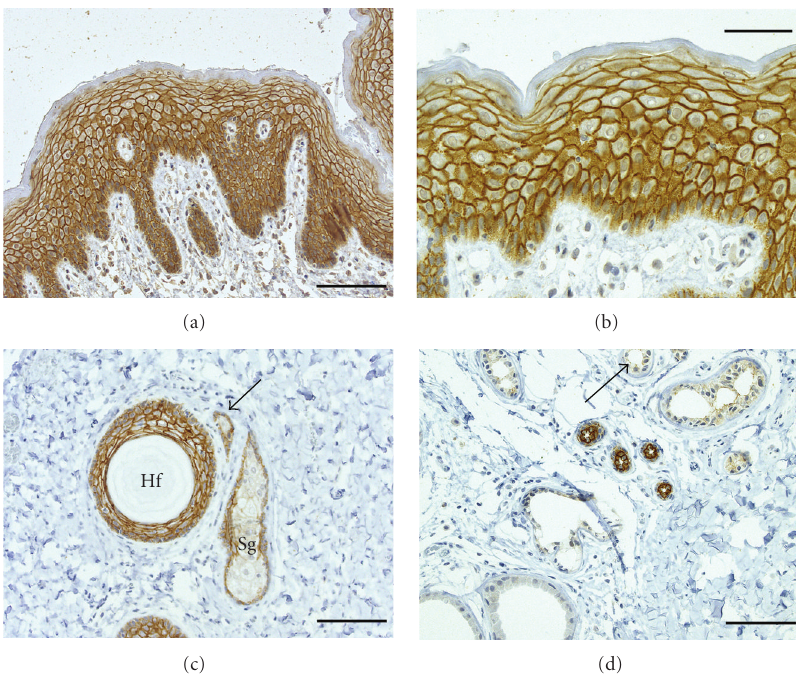
Figure 1: Immunohistochemical staining of sections of human skin with antibodies against PKP 1. Sections of formaldehyde-fixed tissue samples of human skin were stained with a monoclonal antibody (clone PP1 5C2; Progen, Heidelberg; for methods see [18]) against PKP 1 a to d. (a) Overview of epidermis showing a strong reaction of the antibodies at the desmosomes of all layers. (b) At a higher magnification, the basal layers exhibit a somewhat weaker desmosomal staining that can be resolved occasionally into individual spot-like desmosomes containing PKP 1. During keratinocyte di ff erentiation, desmosomal labeling is getting more pronounced. (c) Cross-section of a hair follicle (Hf) with desmosomal staining of the outer root sheath while the hair-shaft is not stained (Sg, sebaceous gland). Arrow marks the duct of a sebaceous gland. (d) Eccrine sweat ducts are marked intensively by antibodies while the secretory portions of eccrine glands show a distinct but weaker staining (arrow). Apocrine sweat glands (lower left corner) are negative. Scale bars: 100 μ m (b); 200 μ m a, c, and